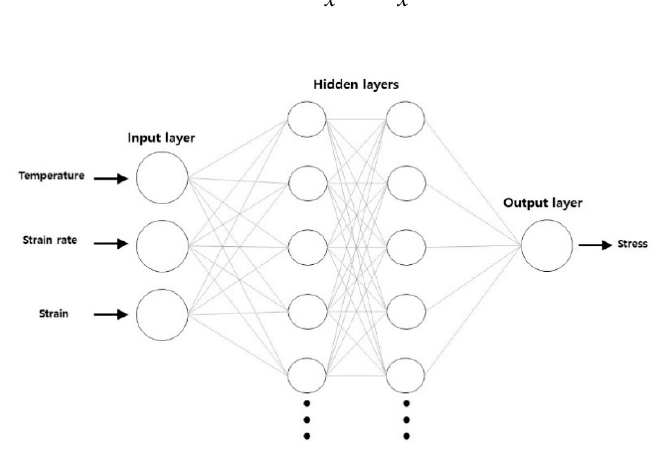
Figure 6. Neural network model. Table 2. Processing parameters for the neural networks.